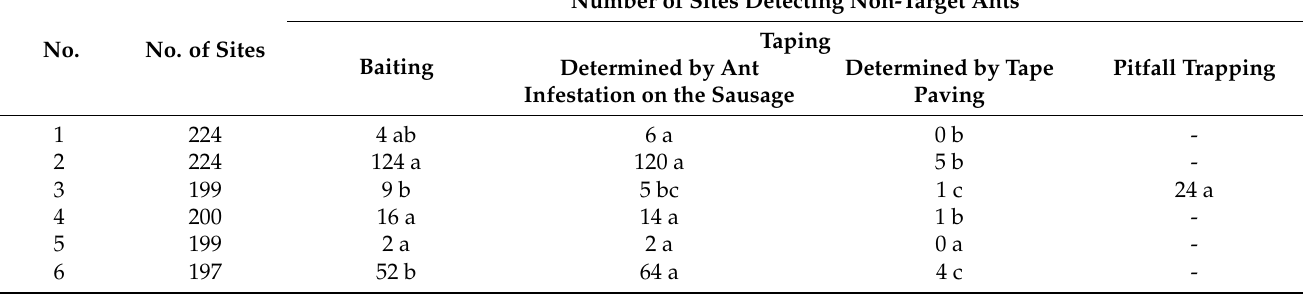
Table 3. Number of monitors (bait, tape, or pitfall trap) detecting non-target ants (ants other than Solenopsis invicta and Tapinoma melanocephalum ) in each location. “-” indicates pitfall traps were not tested in the location. Different letters within the same row indicate significant differences ( p < 0.05). Statistical results are shown in Supplementary Material: Table